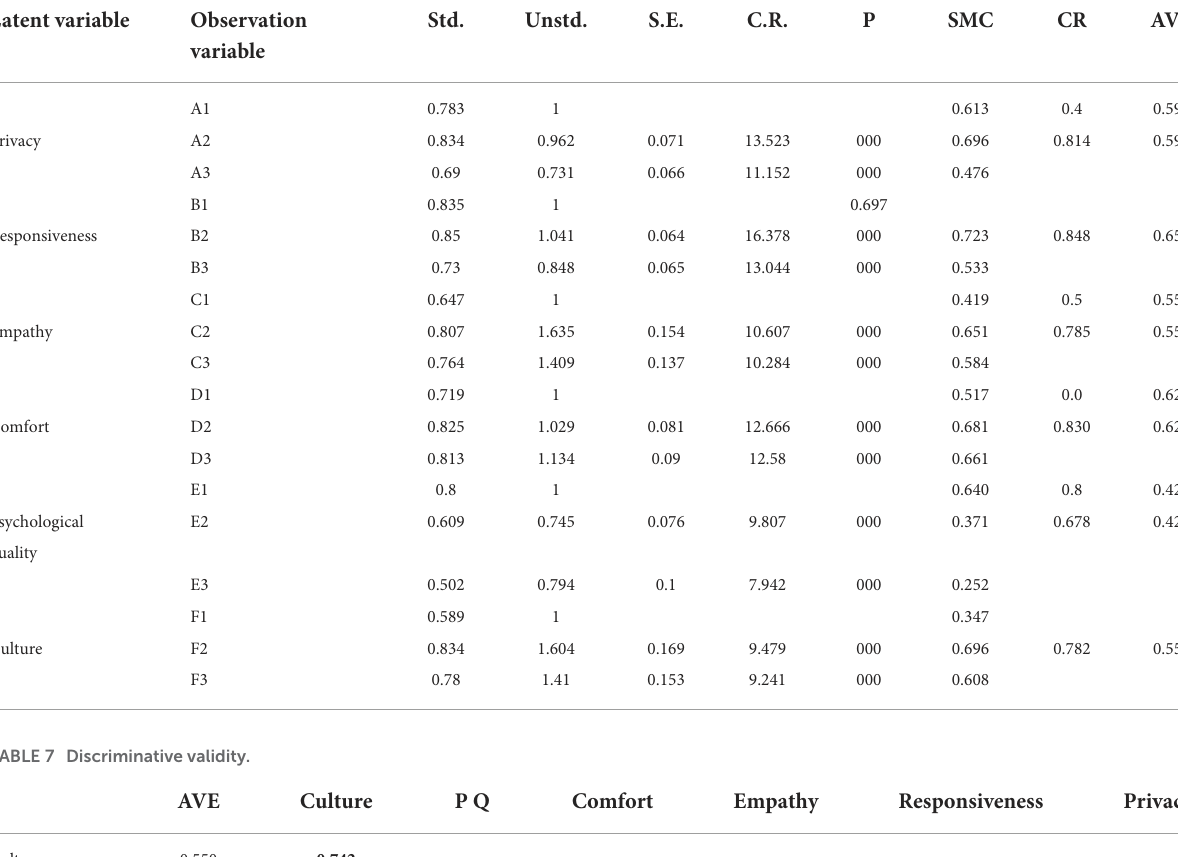
TABLE 6 Convergent validity.